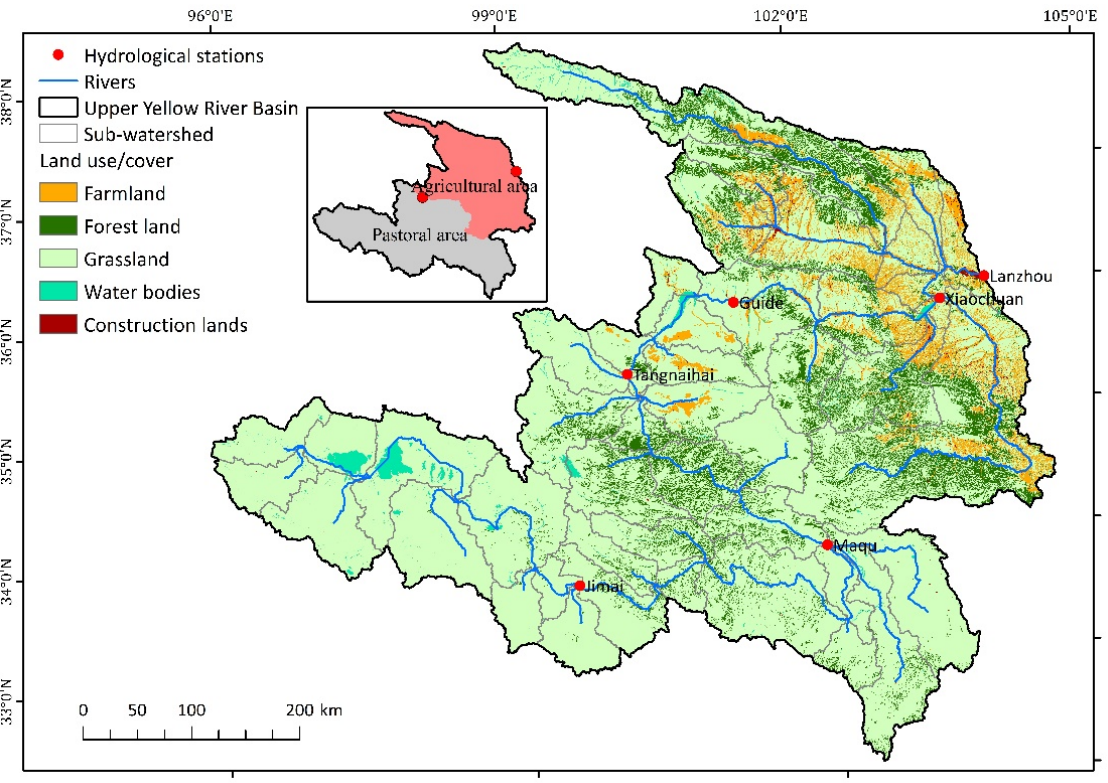
Figure 2. Major types of land-use map from 1990s to 2020s.